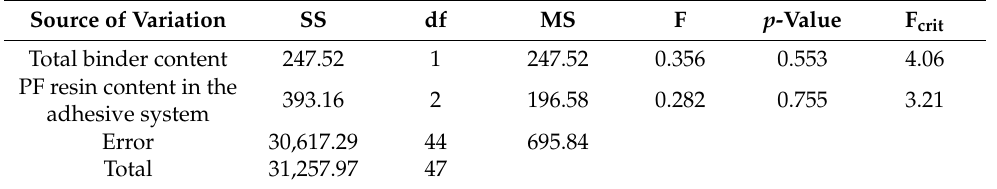
Table 3. ANOVA for the density of fiberboard panels bonded with HL and PF